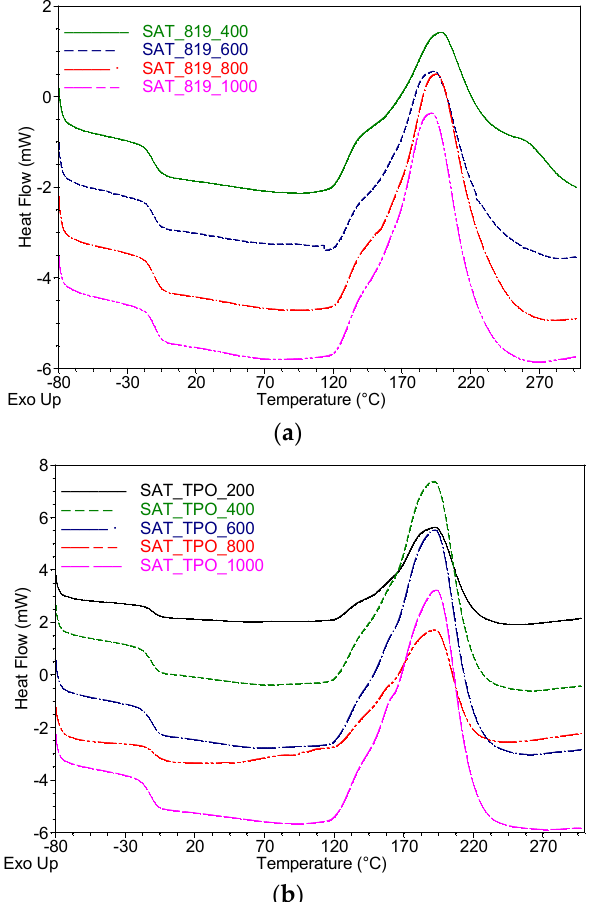
Figure 3. Differential scanning calorimetry (DSC) thermographs for the uncured ( a ) SATs-TPO and ( b ) SATs-819 tapes.